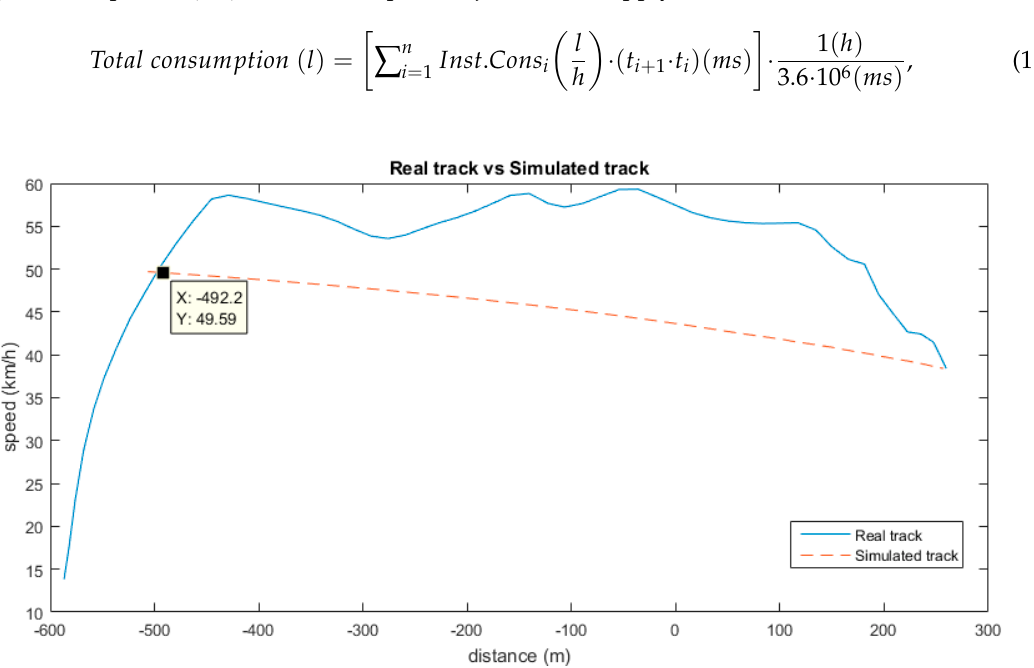
Figure 11. Real versus Simulated track curves.